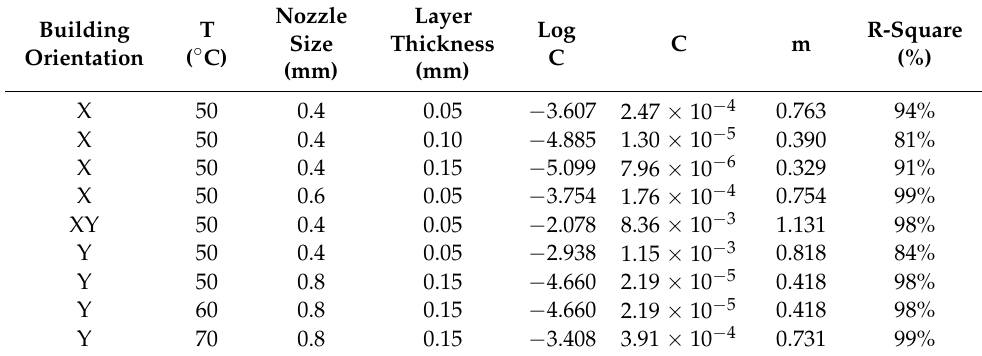
Table 9. The Paris power law constant (C and m) for a part of configurations obtained from